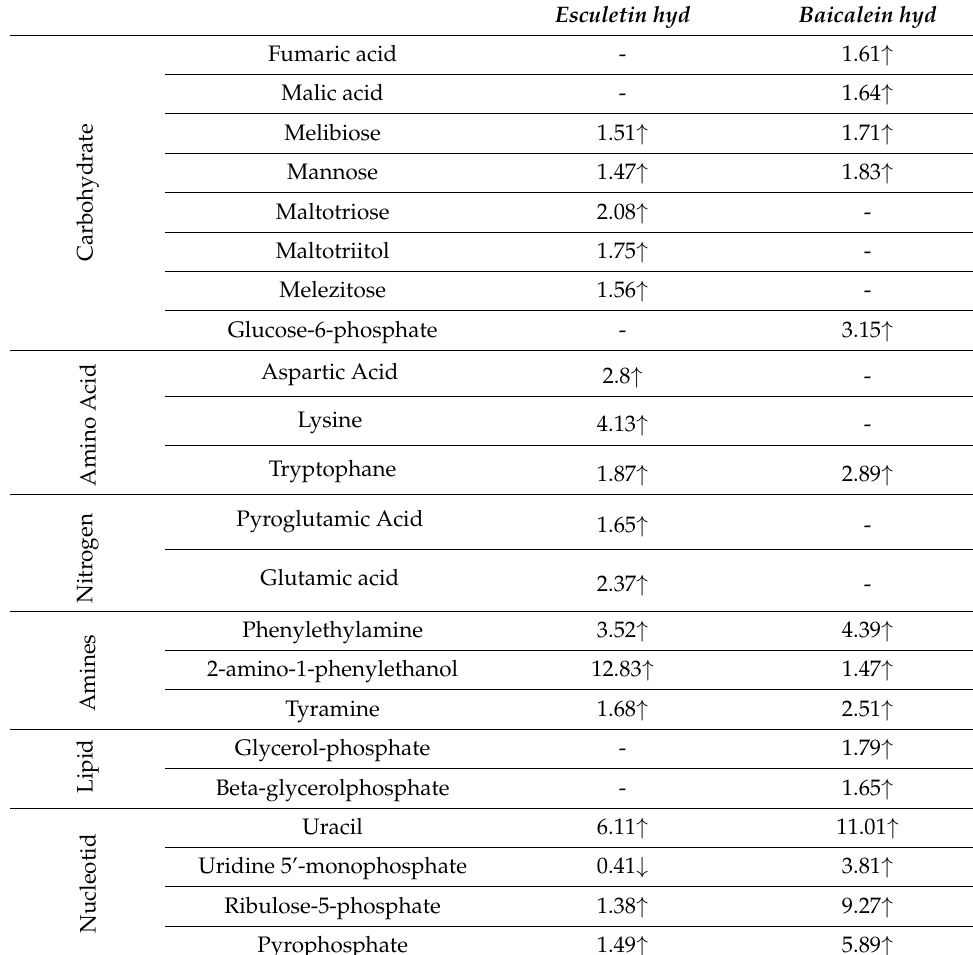
Table 3. Comparison of metabolic profiling of P. aeruginosa biofilm cells treated with ciprofloxacin alone and combinations of ciprofloxacin with baicalein and esculetin hydrate. The biofilm cells were grown in BHI broth at 37 ◦ C for 24 h, followed by further treatment with antimicrobial agents for another 24 h. The results are shown as the